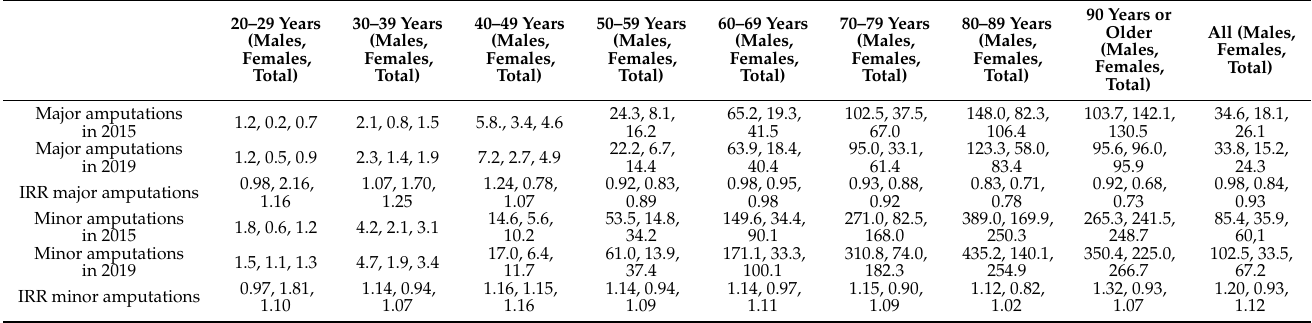
Table 3. Age-adjusted incidence rate of major and minor amputations in the years 2015 and 2019, respectively. IRR = incidence rate